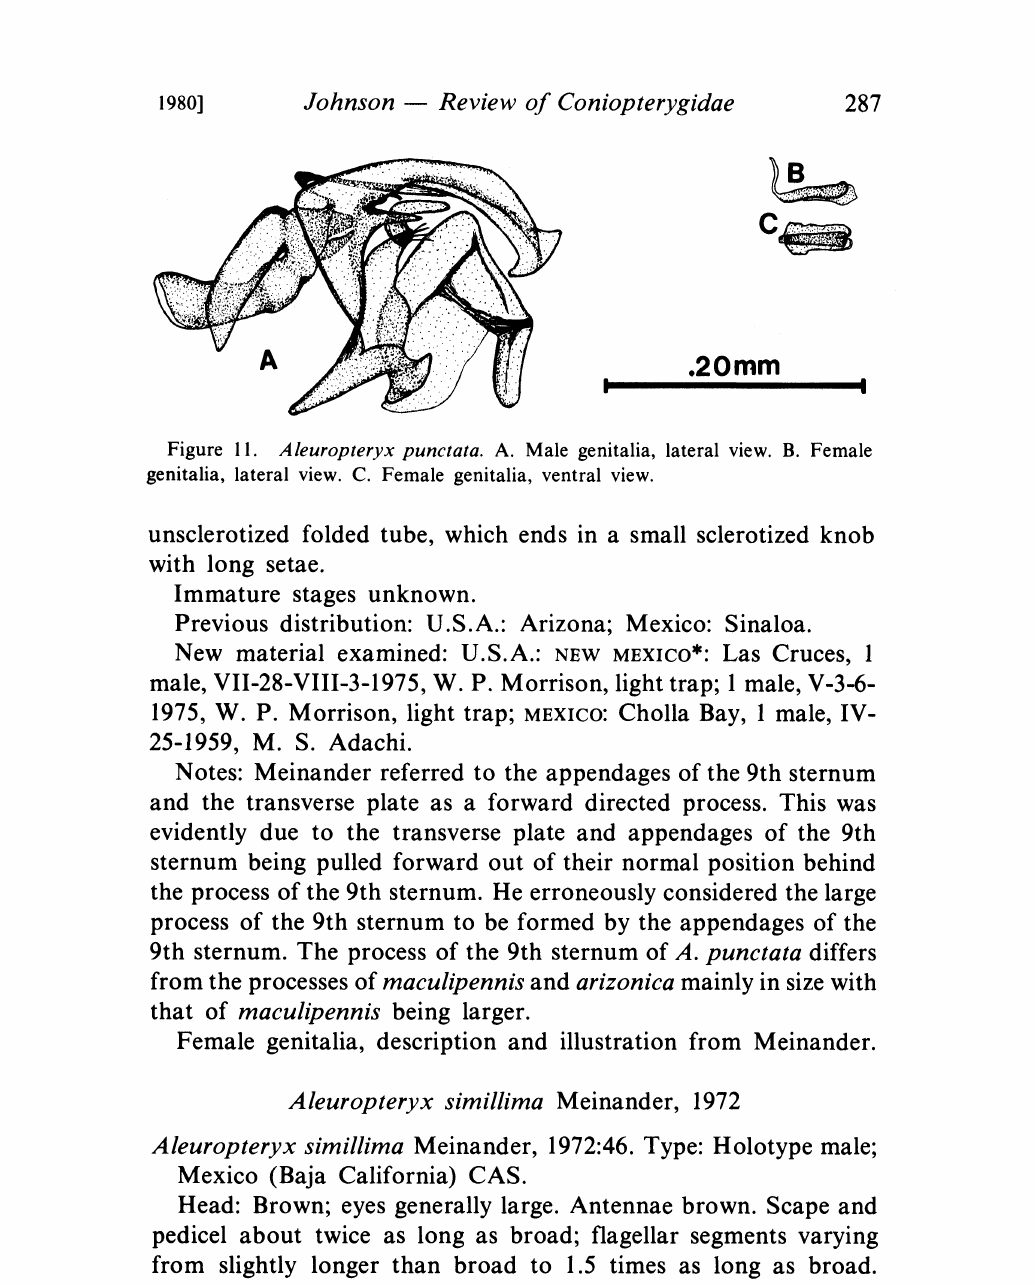
Figure 11. Aleuropteryx punctata. A. Male genitalia, lateral view. B. Female genitalia, lateral view. C. Female genitalia, ventral view. unsclerotized folded tube, which ends in a small sclerotized knob with long